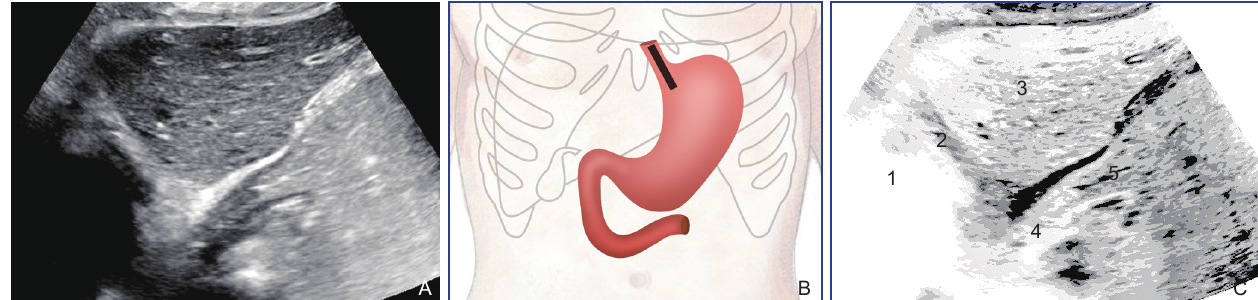
Figure 4 Ultrasonic images and scanning schematic diagram of section of long axis of cardia (scanning under xiphoid process). A, Ultrasound image; B, Scan the schematic diagram; C, Ultrasound Schematic Diagram (1, 2, Diaphragm; 3, Left lobe of liver; 4, Abdominal esophagus; 5, Cardia)